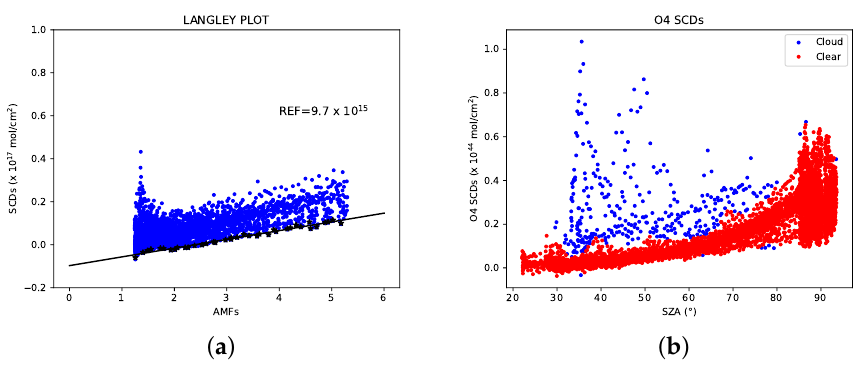
Figure 3. ( a ) Modified Langley plot and ( b ) O 4 SCDs data filtering for SkySpec-2D during the Bologna inter-comparison campaign. Results for NO 2 cross sections at 298